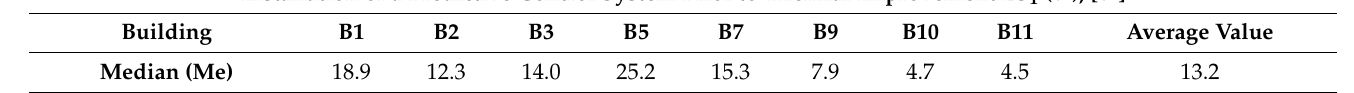
Table 9. Energy savings after using Egain Edge predictive control system in buildings before thermal improvement, ES 1 (%), [%].